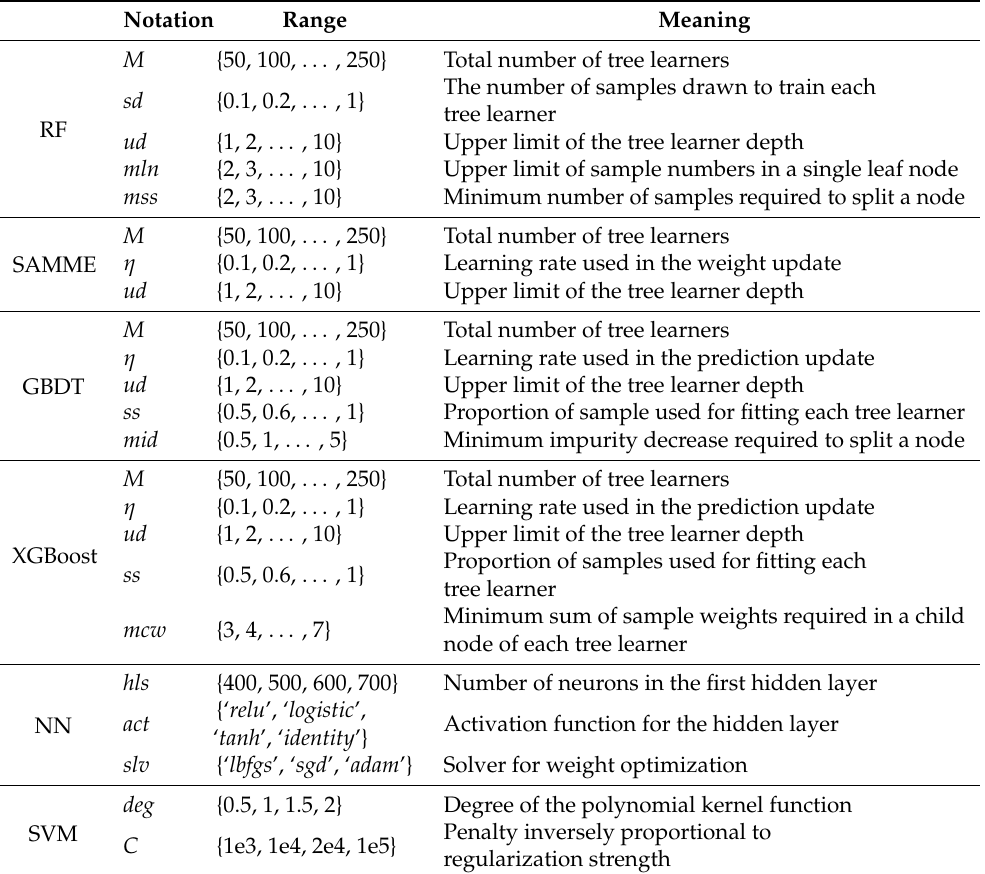
Table 2. Ranges of main tunable hyper-parameters of the tested methods.